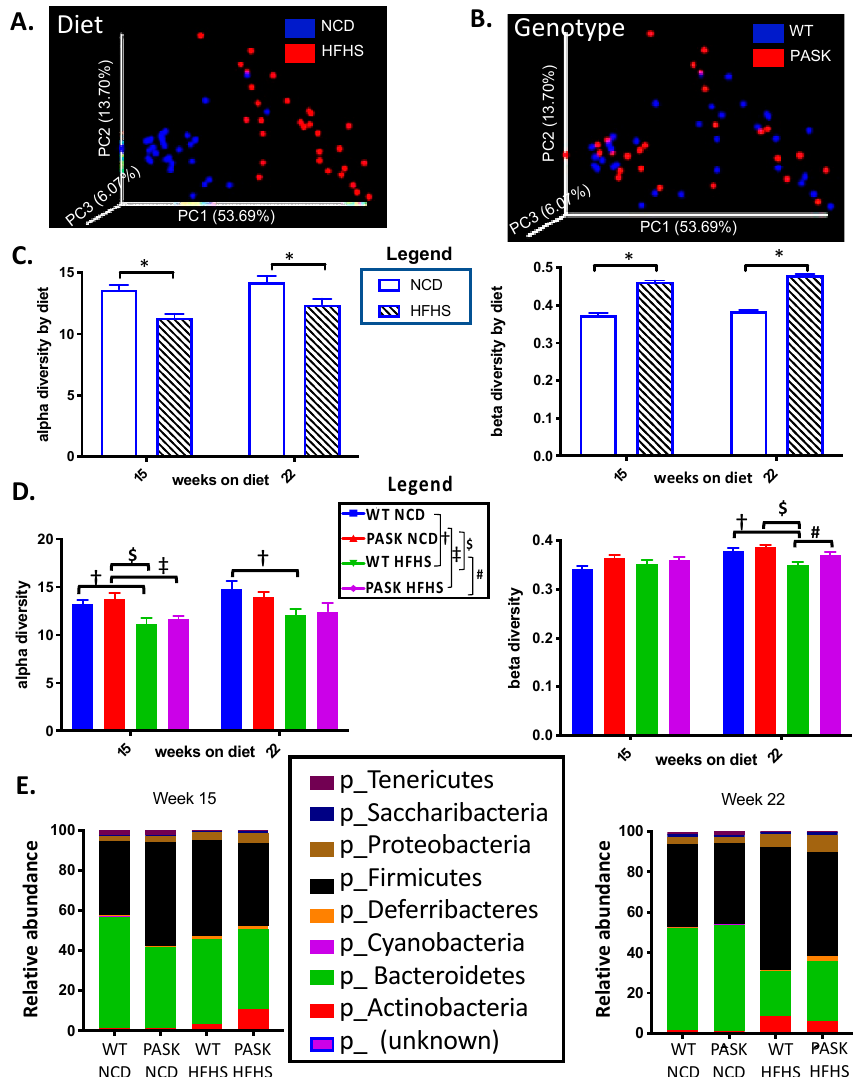
Figure 3. Diet, influenced by genotype, alters gut microbial diversity. ( A ) Comparison of weighted UniFrac principal coordinates analysis (PCoA) distances in microbial diversity at 22 weeks between NCD (blue) and HFHS (red). ( B ) Comparison of weighted UniFrac distances at 22 weeks between WT (blue) and PASK − / − (red). ( C ) Comparison of alpha and beta diversity between NCD and HFHS at 15 weeks ( n = 21–25) and 22 weeks ( n = 27–29). ( D ) Comparison of alpha and beta diversity by diet and genotype. ( E ) Relative abundance at phyla level in week 15 samples and week 22 samples. QIIME2/2017.10. software package [43] was used to analyze the microbiome. Alpha diversity was analyzed by Faith’s phylogenetic diversity [52] and is expressed as mean plus SEM, distances to NCD with Kruskal–Wallis follow-up. Beta diversity is expressed as weighted UniFrac [54] mean plus SEM with permutational multivariate analysis of variance (PERMANOVA) [50]. “*” indicates differences due to diet, namely, all mice on NCD versus all mice on HFHS diet ( p < 0.05). For panel D, factorial ANOVA (JMP Pro version 14) with post hoc Tukey HSD analysis was used to investigate interactions between diet and genotype. P -values less than or equal to 0.065 are shown (WT-NCD compared with WT-HFHS † , PASK-NCD compared with PASK-HFHS ‡ , WT-HFHS compared with PASK-HFHS # , PASK-NCD compared with WT-HFHS $ ). A corresponding legend is provided in the top